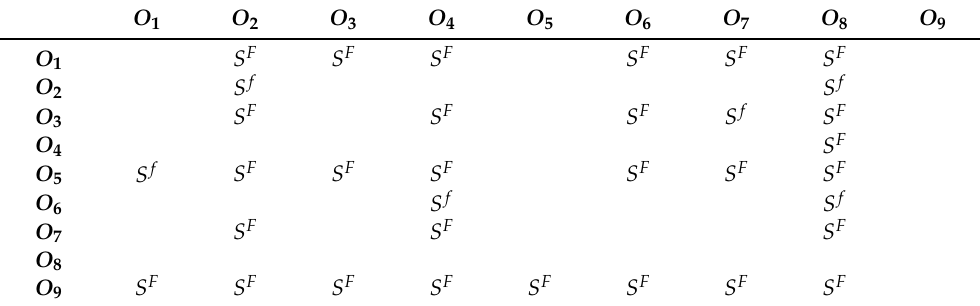
Table 28. Strong and weak outranking relationships for PLTS ELECTRE